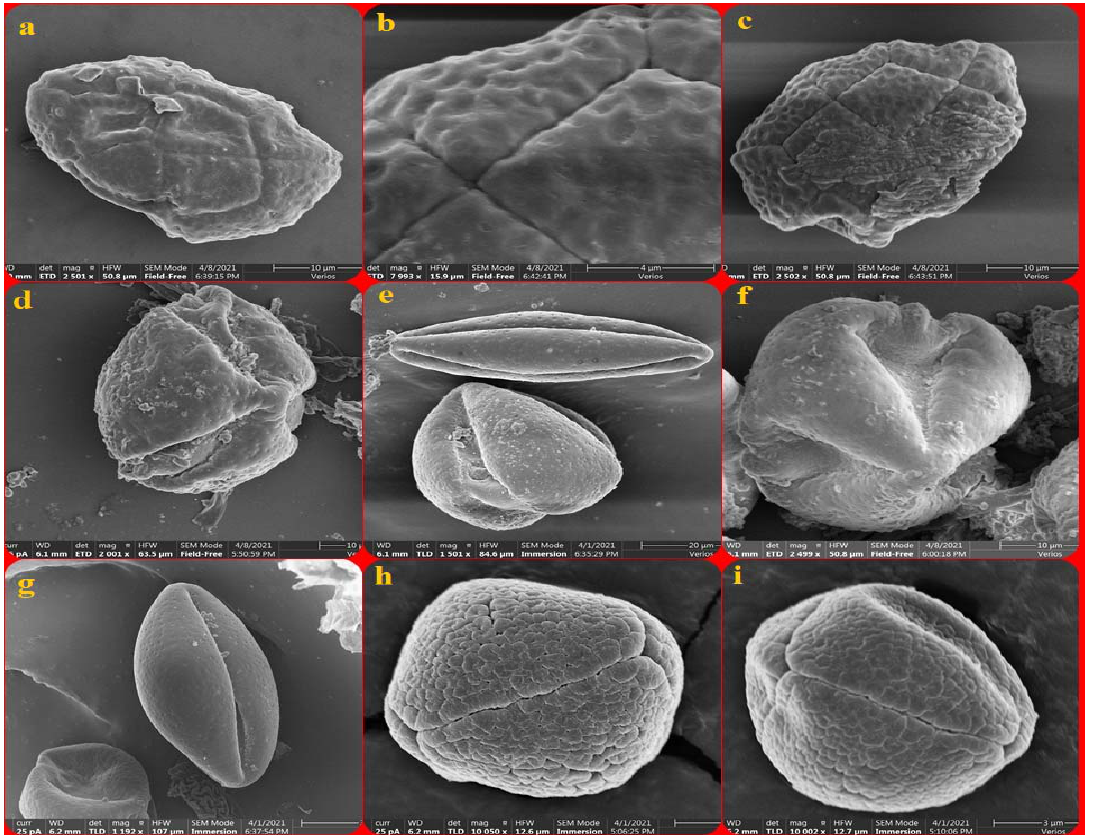
Figure 1. Acacia confusa ( a – c ), showing ( a ) general view of the pollen and ( b ) close view of the exine sculpturing. Entada phaseoloides ( d – g ), showing ( d ) oblique polar view, ( e ) equatorial view, ( f ) sunken colpus and ( g ) zonocolpus. Mimosa pudica Wanning ( h , i ), showing oblique equatorial view. Scale bars: a = 10 µ m; b = 4 µ m; c = 10 µ m; d = 10 µ m; e = 10 µ m; f,g = 10 µ m; h,i = 3 µ